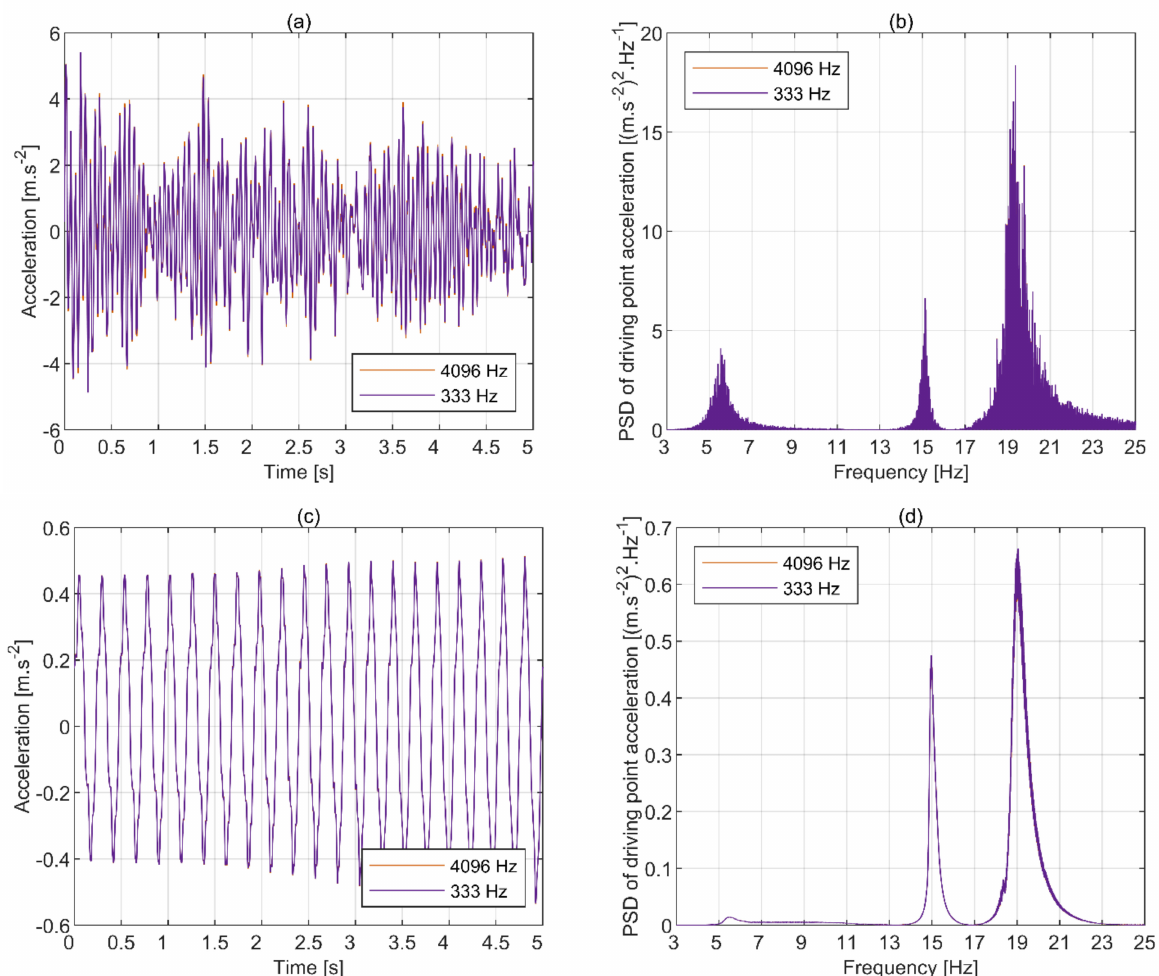
Figure 5. Original and resampled acceleration measured at the excitation point during T2 in ( a ) time and ( b ) frequency domain and the corresponding plots for T4 in ( c , d ). Signals in ( a , c ) were filtered with a 4th order Butterworth filter with cut off frequencies of 3 & 23 Hz and 1 & 23 Hz, respectively. PSDs in ( b , d ) were obtained without averaging and